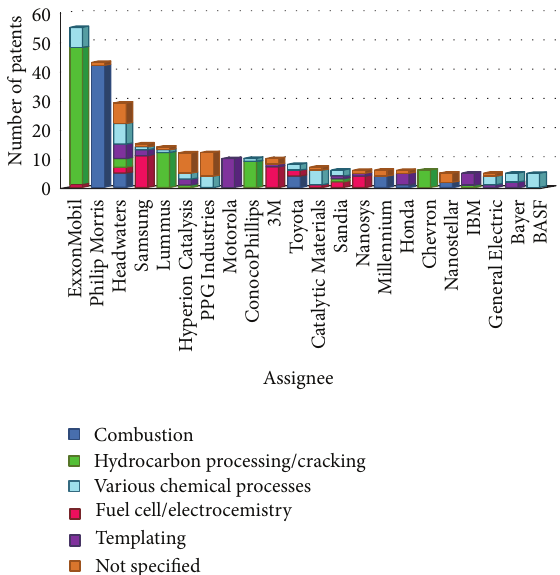
Figure 7: Major assignees of patents related to nanotechnology and respective application fields (based on a research on the US Patent and Trademark Office Patent Database (http://patft.uspto.gov/) applying the working definition stated in the beginning of this review).